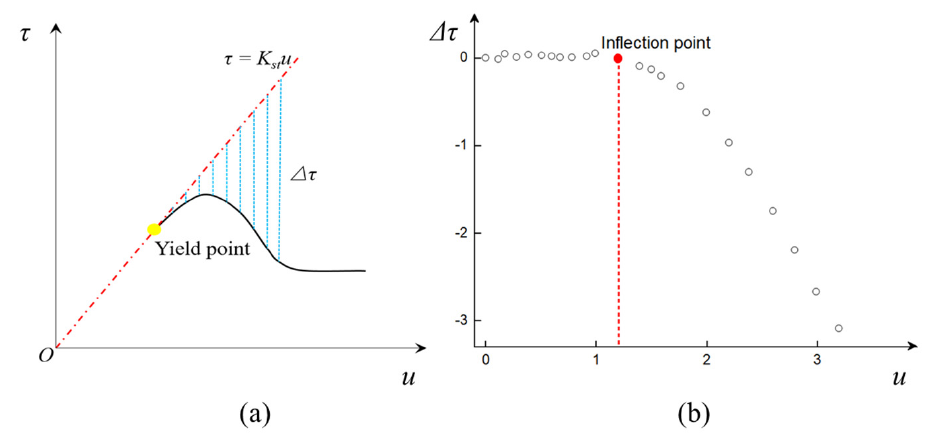
Figure 3. Schematic diagram of the inflection point method, ( a ) τ - u curve ( b ) Δ τ - u curve.